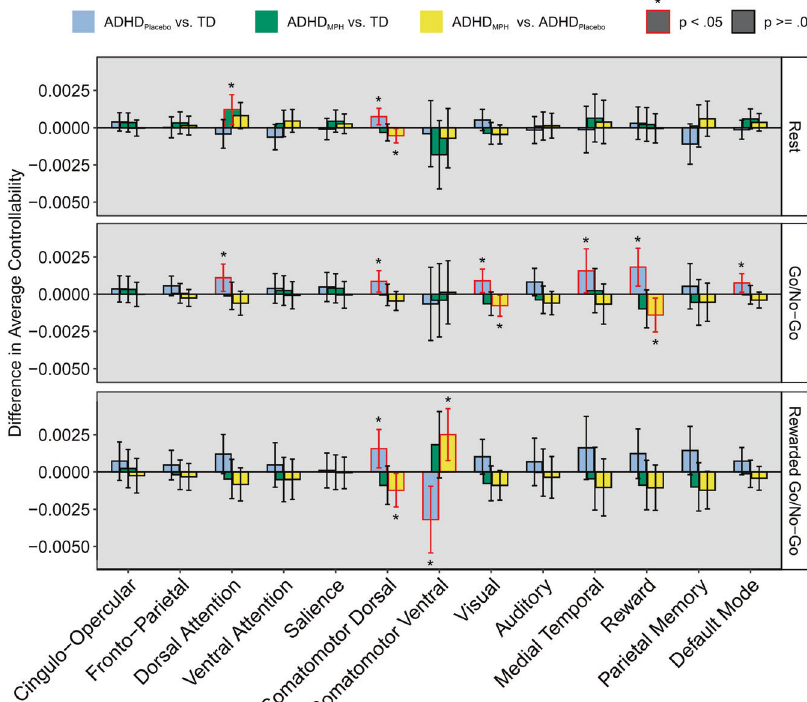
Fig. 2 Difference in average controllability between ADHD on placebo and TD (blue bars), ADHD on MPH and TD (green bars), and within ADHD (yellow bars) for the three functional scan contexts (rest, go/no-go, rewarded go/no-go). Children with ADHD on placebo exhibited increased average controllability in the somatomotor dorsal network during rest, the dorsal attention, somatomotor dorsal, visual, medial temporal, reward, and default mode networks during the go/no-go task, and in the somatomotor dorsal network during the rewarded go/no- go task. Children with ADHD on placebo exhibited decreased average controllability in the somatomotor ventral network during the rewarded go/no-go task. During rest, children with ADHD on MPH exhibited higher average controllability in the dorsal attention network. For all cases in which children with ADHD on placebo exhibited signi fi cantly different average controllability compared to TD children, those differences were no longer signi fi cant when comparing children with ADHD on MPH and TD children. This was supported by signi fi cant within-ADHD effects of MPH for the somatomotor dorsal network during rest, visual and reward networks during the go/no-go task, and the somatomotor dorsal and somatomotor ventral networks during the rewarded go no-go task. Bars correspond to the regression estimate of the relevant difference, controlling for age, biological sex, and in-scanner motion. Error bars correspond to 95% con fi dence intervals. Red outline and asterisk indicate statistical signi fi cance at p < a corresponding signi fi cant within-participant reduction in average controllability associated with MPH ( β ¼ (cid:2) 0 : 0005 ; p ¼ 0 : 04). Addi- tionally, children with ADHD on MPH had signi fi cantly increased average controllability relative to TD children in the dorsal attention network ð β ¼ 0 : 0012 ; p ¼ 0 : 02 Þ ; this difference was not present in children with ADHD on placebo. All other effects were non-signi fi cant (all p- values > 0.07; Fig. 2). During the go/no-go task, children with ADHD on placebo exhibited increased average controllability in the dorsal attention ( β ¼ 0 : 001 ; p ¼ 0 : 02), somatomotor dorsal ( β ¼ 0 : 001 ; p ¼ 0 : 02), visual ( β ¼ 0 : 0008 ; p ¼ 0 : 03), medial temporal ( β = 0.002, p = 0.04), reward ( β ¼ 0 : 002 ; p ¼ 0 : 007), and default mode ( β = 0.0008, p = 0.02) networks relative to TD children. These group differences were not present when children with ADHD were on MPH (all p- values > 0.11). There were corresponding signi fi cant within-participant reductions in average controllability associated with MPH for the visual ( β ¼ (cid:2) 0 : 0008 ; p ¼ 0 : 04) and reward ( β ¼ 0 : 0014 ; p ¼ 0 : 02) networks. All other effects were non-signi fi cant (all p- values > 0.05; Fig. 2). During the rewarded go/no-go task, children with ADHD on placebo exhibited increased average controllability relative to TD children in the somatomotor dorsal network ( β ¼ 0 : 0016 ; p ¼ 0 : 02) and decreased average controllability in the somatomotor ventral network ( β ¼ (cid:2) 0 : 003 ; p ¼ 0 : 01), with no signi fi cant differences between TD children and children with ADHD on MPH in either of these networks (both p- values > 0.10). In both cases there was a